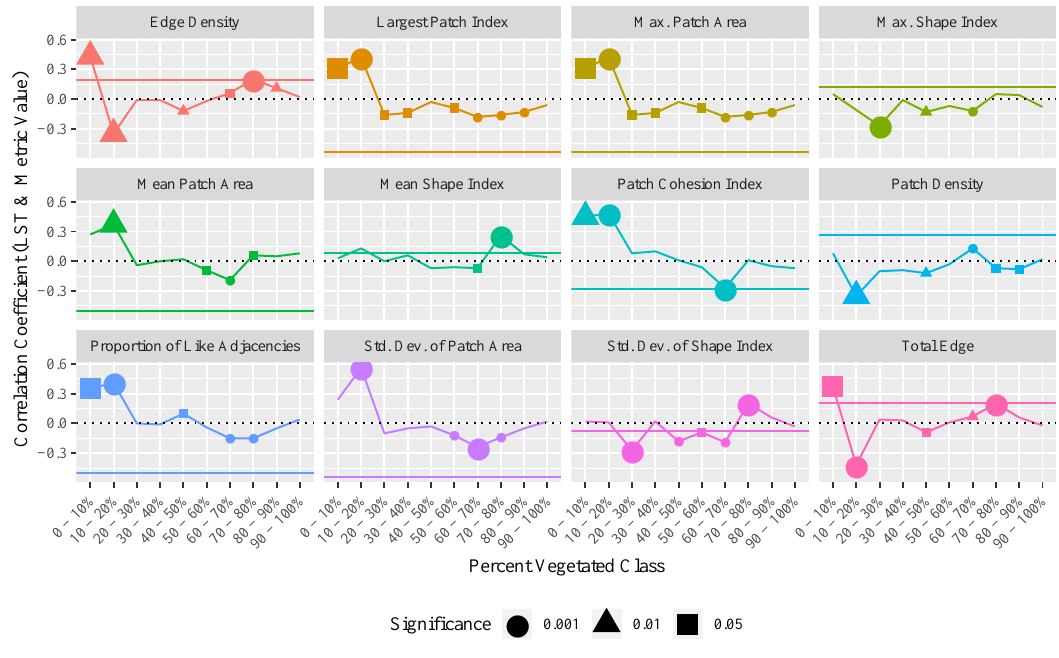
Figure 6. Correlations between metrics and LST by percent vegetated class. The dotted line indicates where the correlation changes sign and the colored line shows the correlation between metrics and LST without controlling for the percent of vegetation. Large significance symbols indicate r ≥